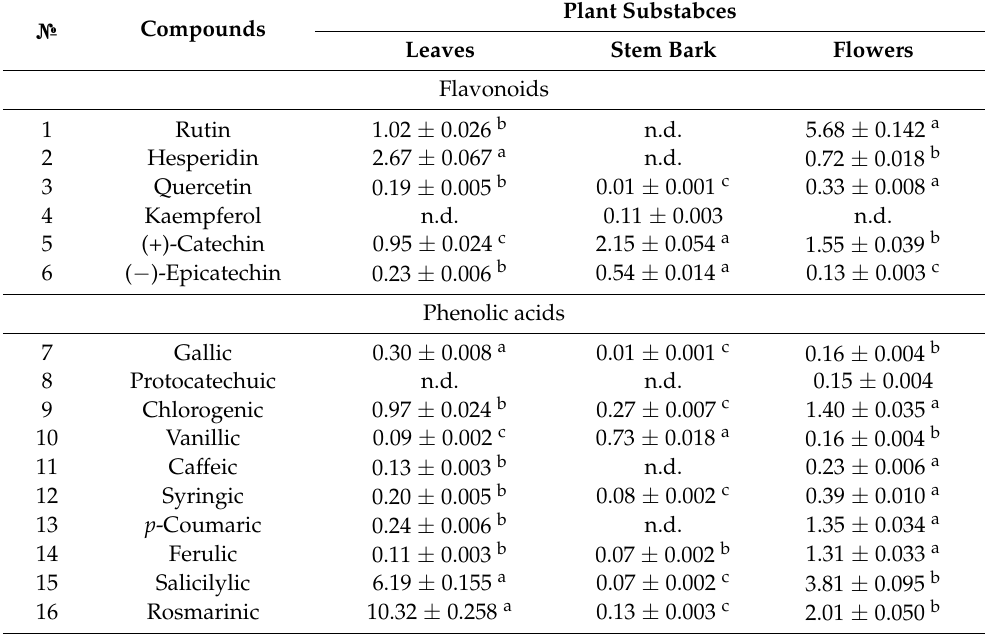
Table 1. Content of flavonoids and phenolic acids in Ailanthus altissima aerial plant substances (mg/g dw). Plant Substabces № Compounds Leaves Stem Bark Flowers